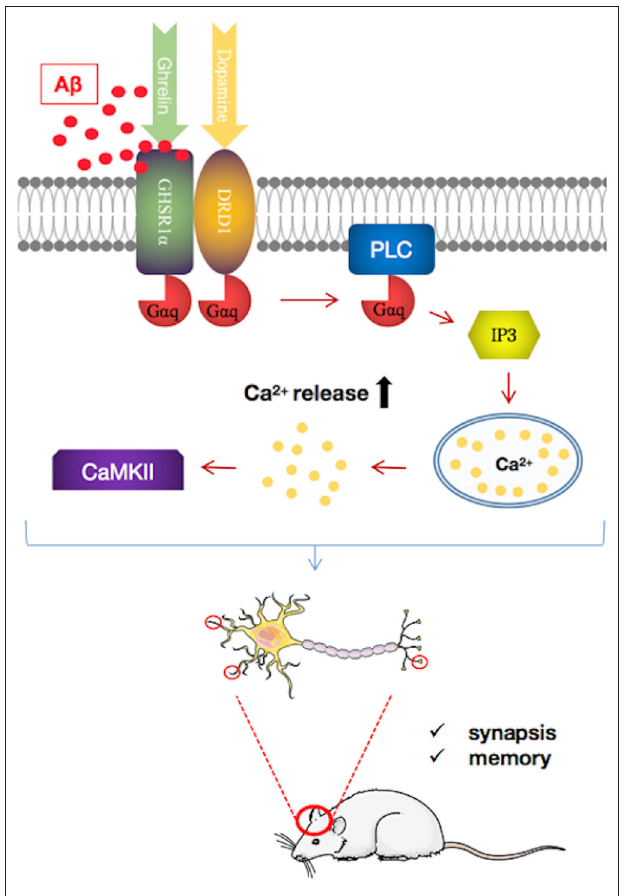
FIGURE 3 | Pathways regulating growth hormone secretagogue receptor 1 α (GHSR1 α )/dopamine receptor D1 (DRD1) interaction by amyloid beta (A β ) in the hippocampus of patients with Alzheimer’s disease (AD). A β binds directly to GHSR1 α and inhibits the activation of GHSR1 α and prevented GHSR1 α /DRD1 heterodimerization, resulting in synaptic plasticity damage and memory loss. In a mouse model of AD, simultaneous use of the selective GHSR1 α agonist MK0677 and the selective DRD1 agonist SKF81297 rescued GHSR1 α function from A β inhibition, thereby reducing hippocampal synaptic damage and improving spatial memory.